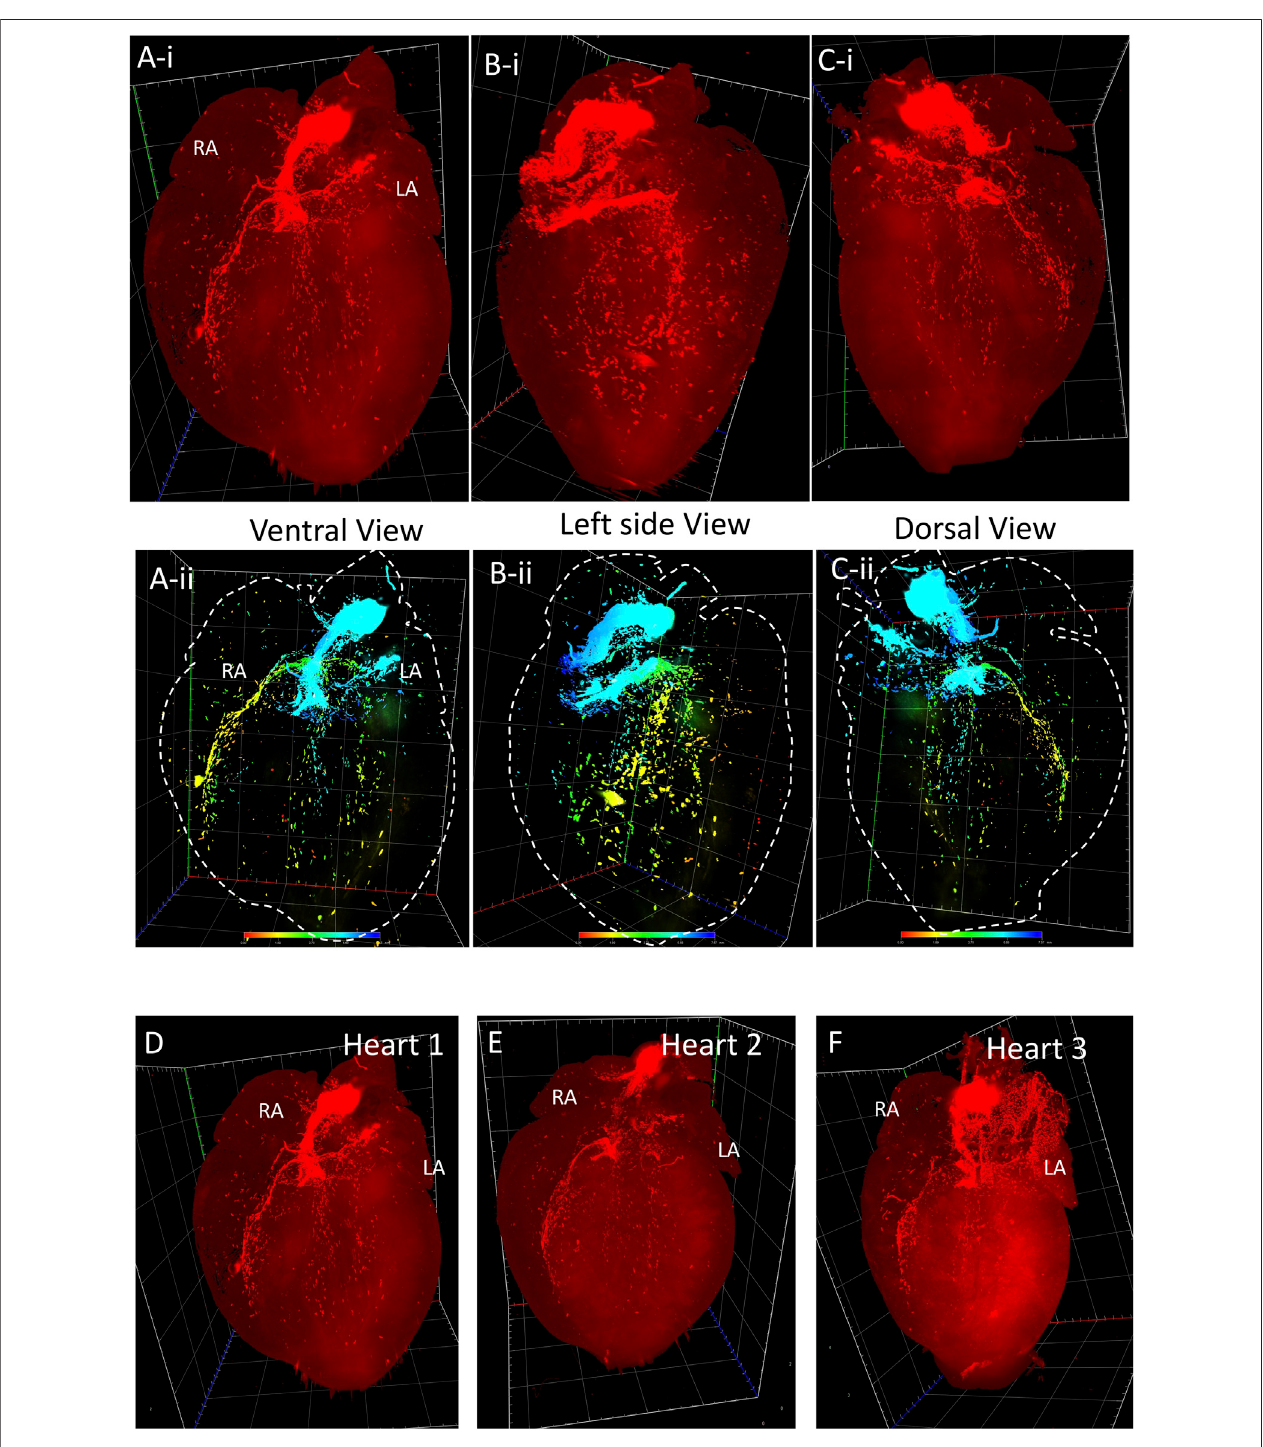
FIGURE 2 | 3D volume reconstruction of the spatial distribution of HCN4+ pacemaker cells in adult Hcn4 DreER/tdTomato mouse heart. (Ai – Ci) The tdTomato fl uorescence images show the distribution of HCN4+ cells from the ventral, left side, and dorsal view respectively (also see online video 1, heart size: 10.05 mm × 12.01 mm x 7.565 mm). (Aii – Cii) The depth code image showing the distribution of HCN4+ cells from the ventral, left side, and dorsal view respectively, corresponding to (Ai – Ci) (also see online video 2). (D – F) Three representatives of tdTomato fl uorescence image showing the consistent signal pattern in adult Hcn4 DreER/tdTomato mouse hearts. (n number = 3). LA: left atrium; RA: right atrium.